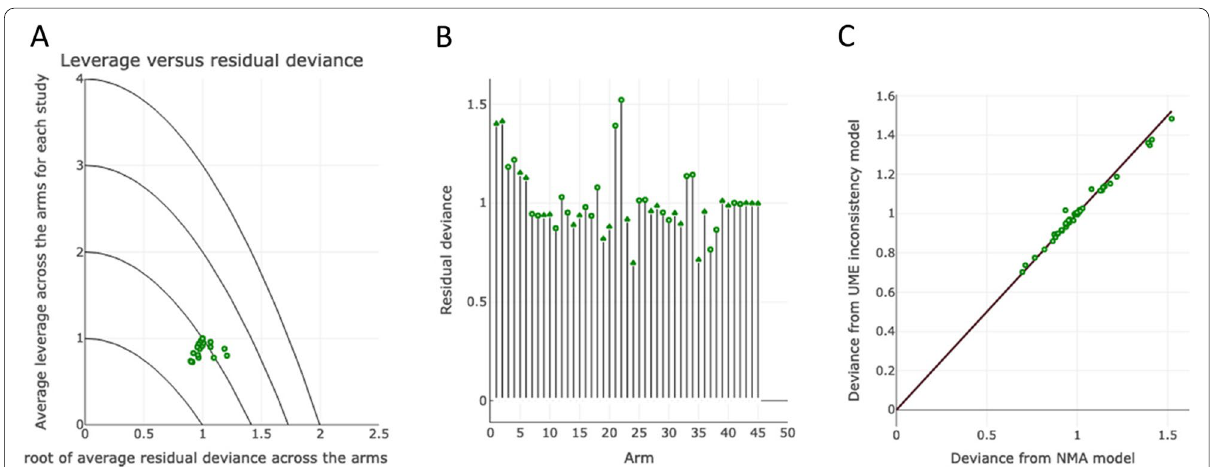
Fig. 5 A Leverage versus residual deviance. The leverage plot helps to assess model fitness. Points that lie outside the line with average leverage of 3 can generally be identified as contributing to the model’s poor fit. All included studies (represented by the green dots) were congregated between the average leverage parabola lines of 1.5 and 2.5, indicating that all studies fitted well in the model. B The stem plot represents the posterior residual deviance of each study arm. The number of stems represents the 43 study arms compared in the network meta-analysis. Each stem indicates the residual deviance of each arm in each included study. The shorter the stem, the smaller the residual deviance, the better the model fit for each data point. None of the stems featured residual deviance greater than 2 – reflecting the model’s fitness. C This plot represents each arm’s contribution to the residual deviance for the NMA (x-axis) and the unrelated mean effect (UME) inconsistency models (y-axis) along with the line of equality. The points on the equality line means there is no improvement in model fit when using the inconsistency model, suggesting that there is no evidence of inconsistency. Points above the equality line means they have a smaller residual deviance for the consistency model indicating a better fit in the NMA consistency model and points below the equality line means they have a better fit in the UME inconsistency model. Most of the included study arms were found on the equality line indicating minimal inconsistency and optimum model